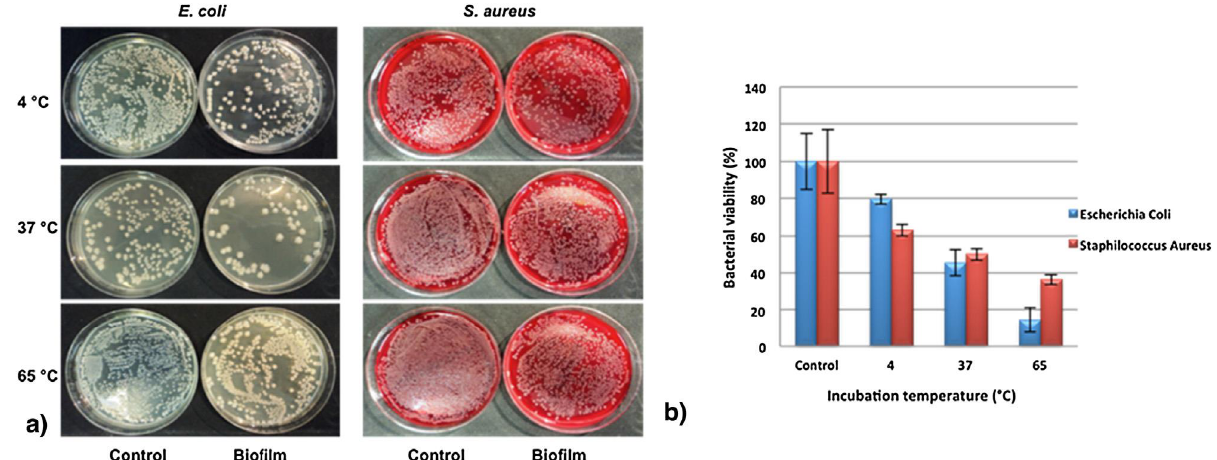
Figure 9. Antibacterial activity of pectin/HNT/PO films against E. coli and S. aureus at 4, 37, and 65 °C incubated for 30 min. ( a ) Photographs of petri dishes; ( b ) viability (expressed as% bacterial viability) of E. coli and S. aureus onto pectin/HNT/CB/PO films after incubation at the three different temperatures. Reproduced with permission from [76].